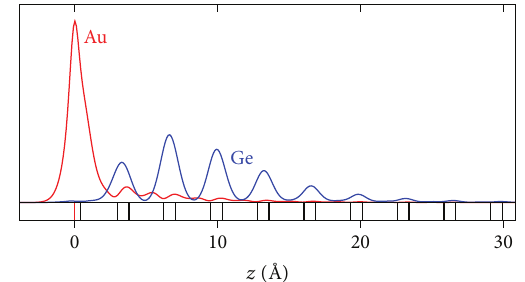
Figure 4: Planar average of the modulus square of the wave functions chosen in Figure 3(b). The red curve with the label “Au” corresponds to the surface state of the Au- and electron-like character. The blue curve with the label “Ge” corresponds to the Ge- and hole-like character. The 𝑧 -zero is at the position of the Au- plane. The red and black balks in the bottom of the figure show the 𝑧 positions of the Au and Ge atomic